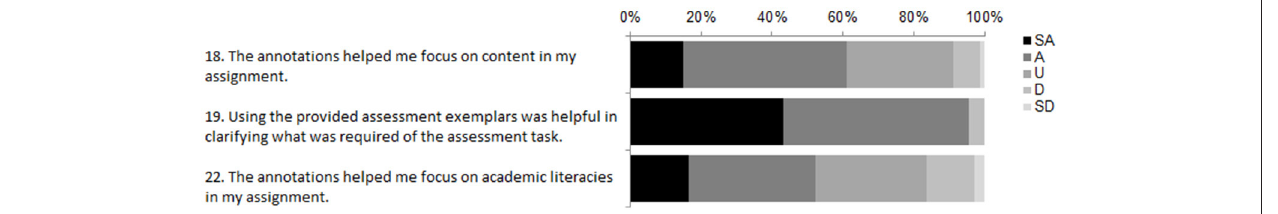
FIGURE 2 | Responses to questions about explicit support.